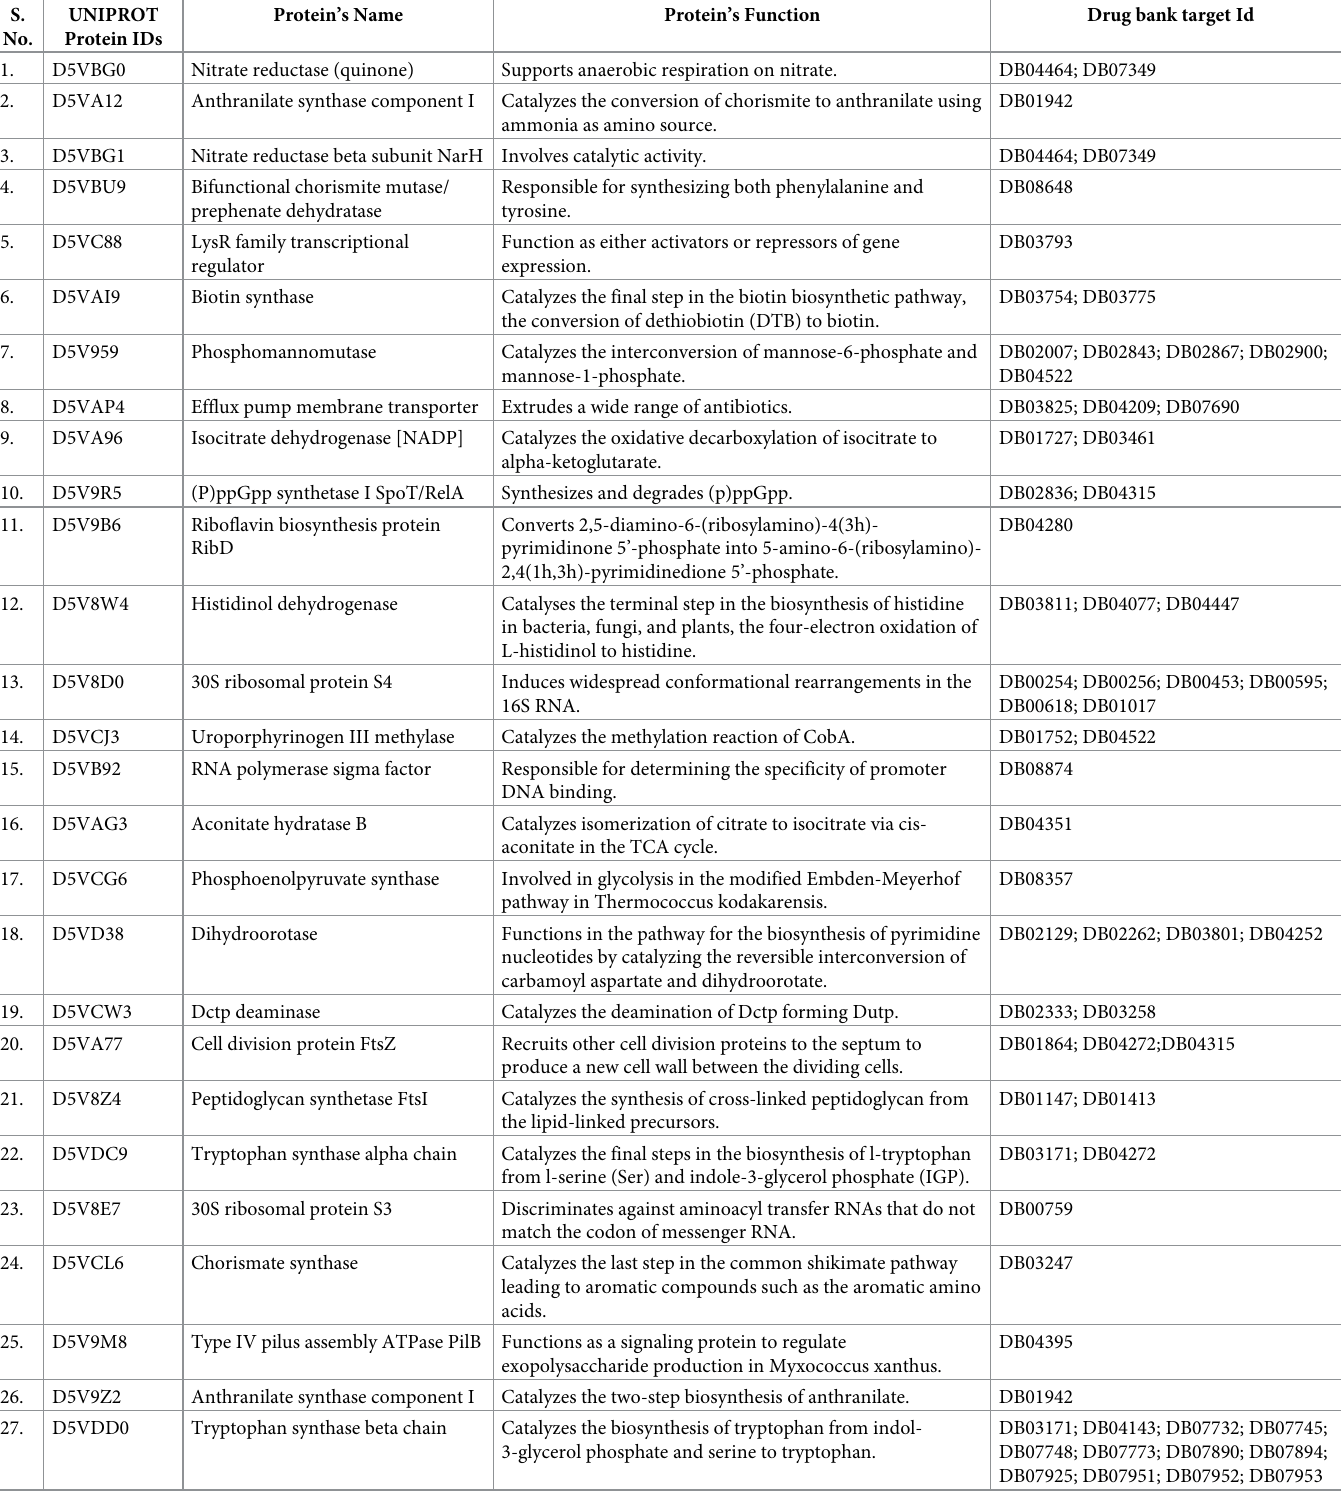
Table 3. Non-homologous essential drug targets: 38 identified drug targets along with their proposed drug bank target ID. S.